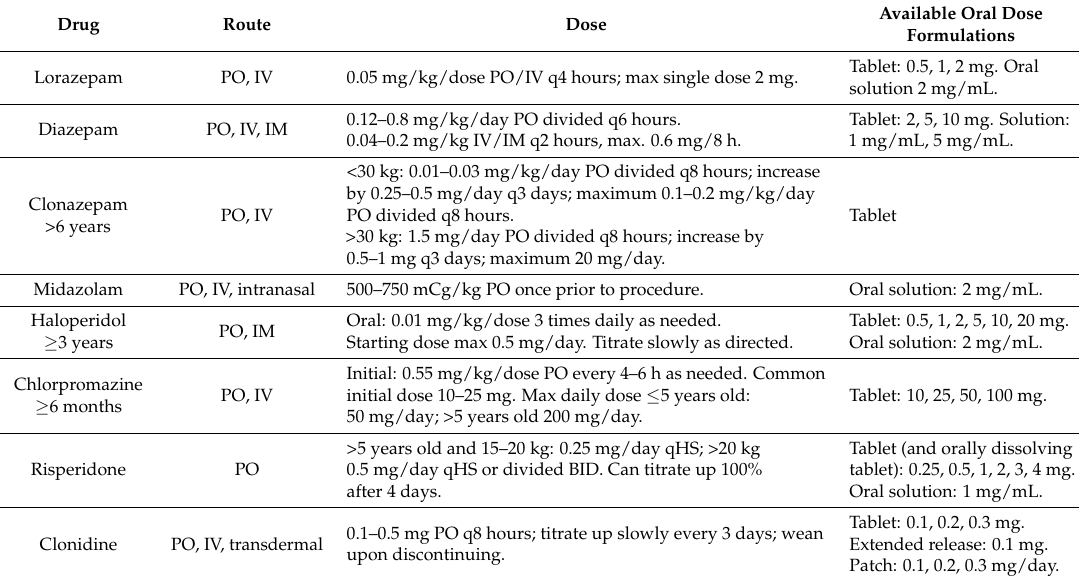
Table 8. Medical treatments for